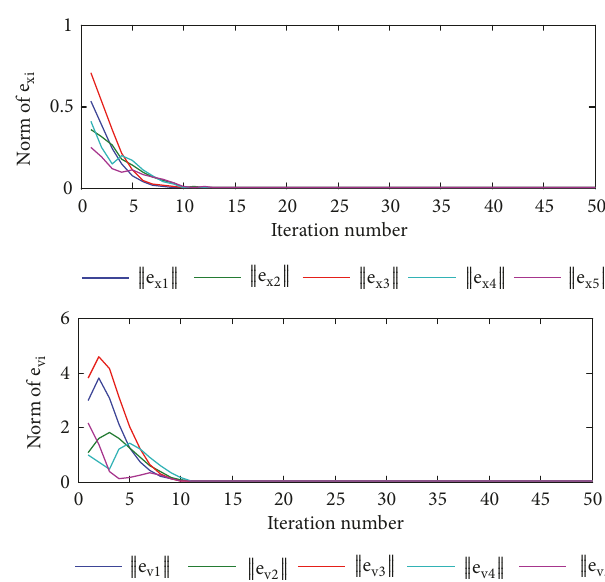
Figure 3: Error norms of position and